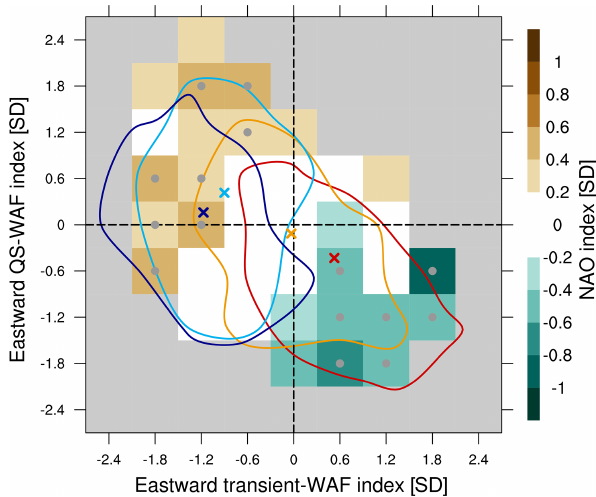
Figure 10. December to March monthly mean NAO index (color shading) as a function of the standardized eastward transient- WAF ( M x ) and the QS-WAF ( F x ) indices (definition in the main text) for the five simulations with stratospheric nudging (a total of 396 years). Grey dots in the middle of each cell indicate statistically significant values at the 95% confidence level according to a t test with at least 10 data points. Light grey cells correspond to combina- tions of the WAF indices with less than 10 events. Colored contours represent the 2-D distribution of the number events for each ENSO experiment (red: strong EN, orange: moderate EN, light blue: mod- erate LN, dark blue: strong LN), where only the 10-event contour is shown for clarity, and where crosses indicate the mean values of the WAF indices for each of the ENSO forcing